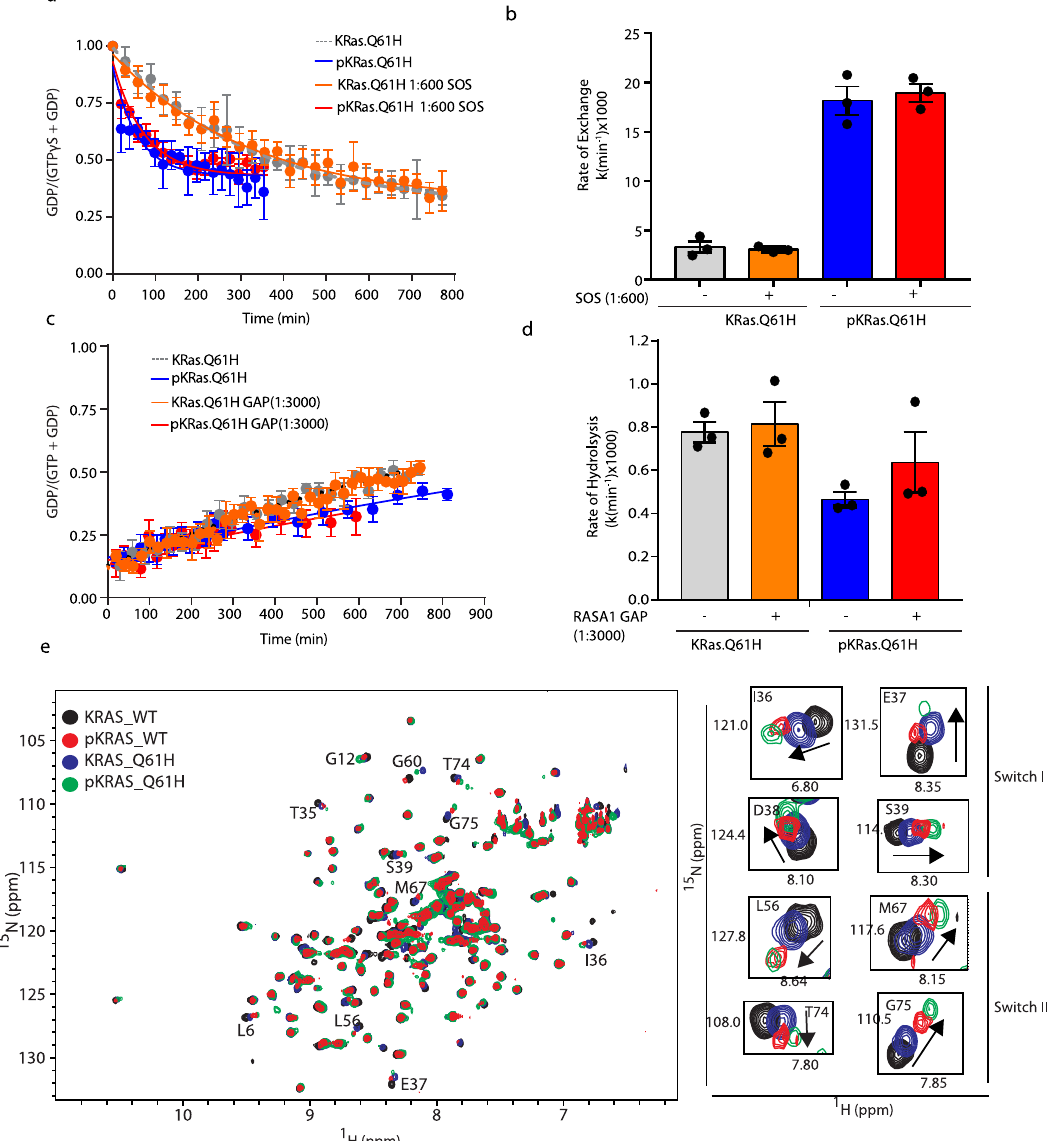
Fig. 4 Phosphorylation enhances the intrinsic exchange of KRAS Q61H. a Intrinsic and SOS cat (1 : 600 molar ratio) assisted KRAS nucleotide-exchange curves of unmodi fi ed and phosphorylated KRAS Q61H. b Nucleotide-exchange rates derived by fi tting the curves in a . c Intrinsic and RASA1 GAP (1 : 3000 molar ratio)-catalyzed KRAS-GTP hydrolysis curves of unmodi fi ed and phosphorylated KRAS Q61H. d GTP hydrolysis rates derived by fi tting the curves in c . e Overlaid 1 H- 15 N HSQC NMR spectra of wild-type KRAS (WT) and the Q61H mutant, as well as their phosphorylated forms (pWT and pQ61H). Peaks for selected Switch I and II residues are expanded on the right. a – e Phosphorylated KRAS samples were generated by incubating 15 N-KRAS with Src (1 : 250 ratio) and ATP followed by passage through a Superdex 75 10/300 column (GE Healthcare). Nucleotide exchange and hydrolysis rates were measured using real-time NMR, starting with fully GDP- and GTP-loaded KRAS Q61H samples, respectively. a , c Dots represent the fraction of KRAS that is GDP loaded ( I GDP / I GDP + I GTP γ S ) based on the intensities of peaks from three residues. The line was obtained by fi tting a one-phase exponential decay curve. Error bars indicate the SEM of the rate calculated from three residues peak intensities. b , d Histograms indicate the mean exchange or hydrolysis rates calculated from intensities of three residues. The error bars represent SEM of the respective